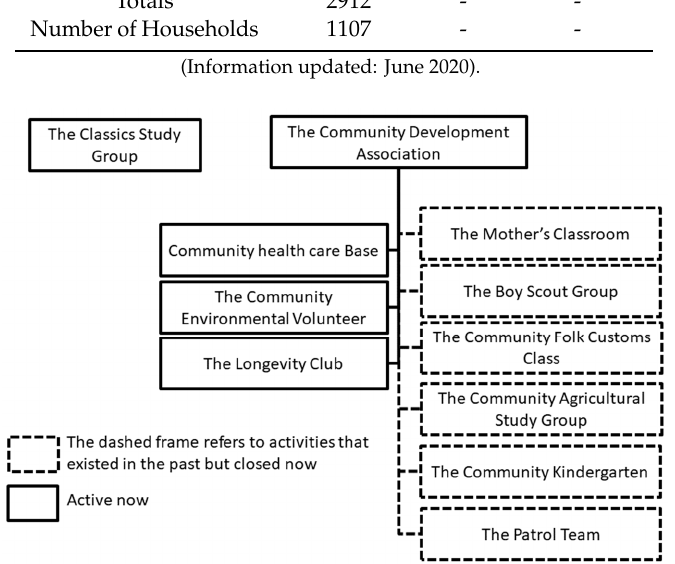
Figure 1. Organization overview of the target community.